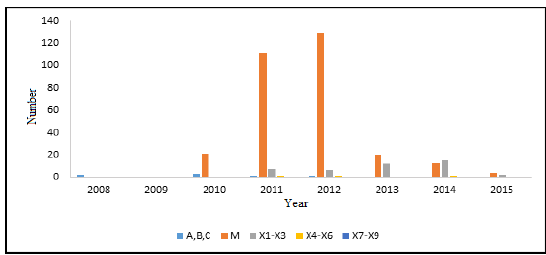
Figure 1. Solar flare events for solar cycle 24 recorded